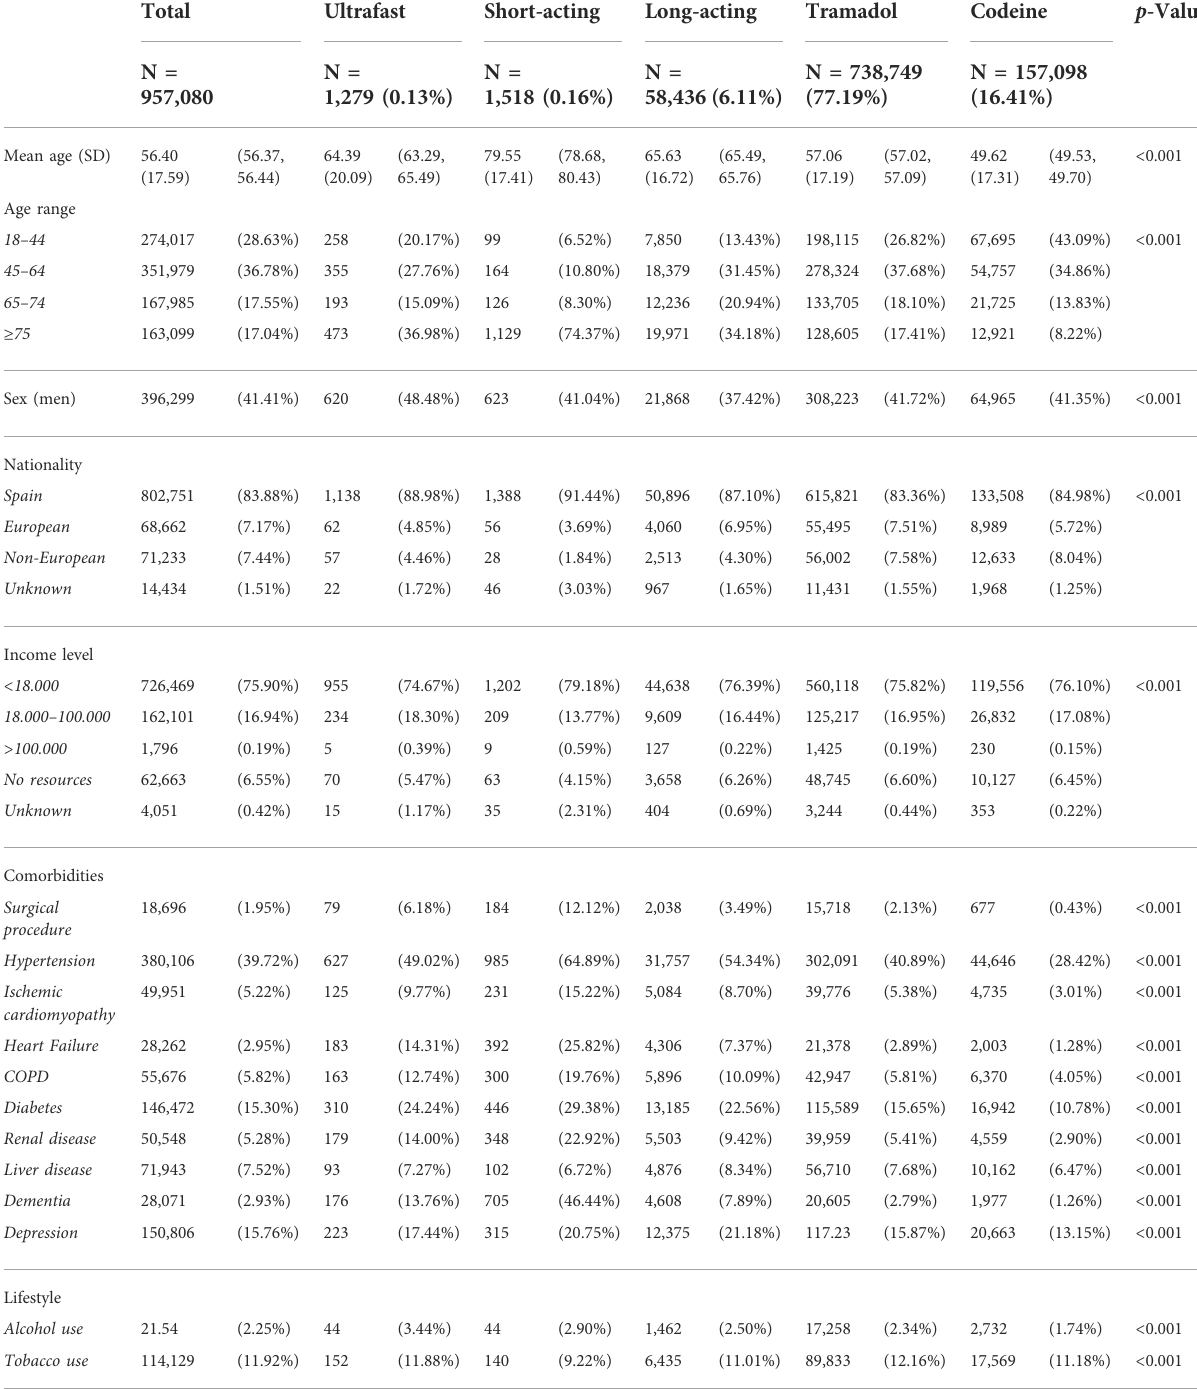
TABLE 1 Patient characteristics at baseline, overall and per type of opioid, n